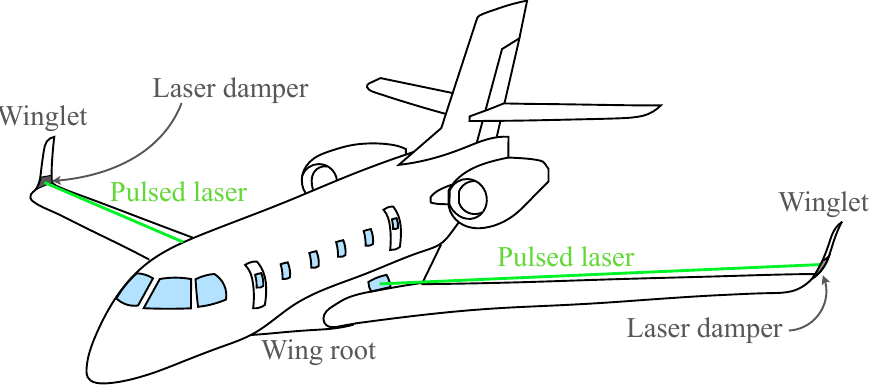
Figure 20. Laser actuator for actual